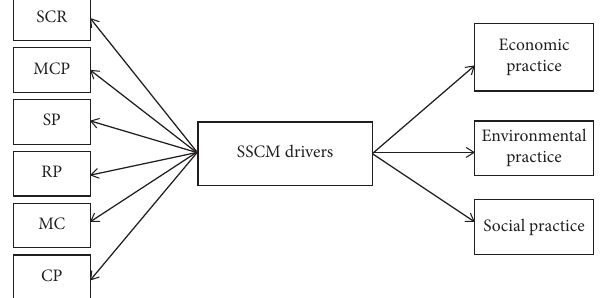
Figure 3: Conceptual